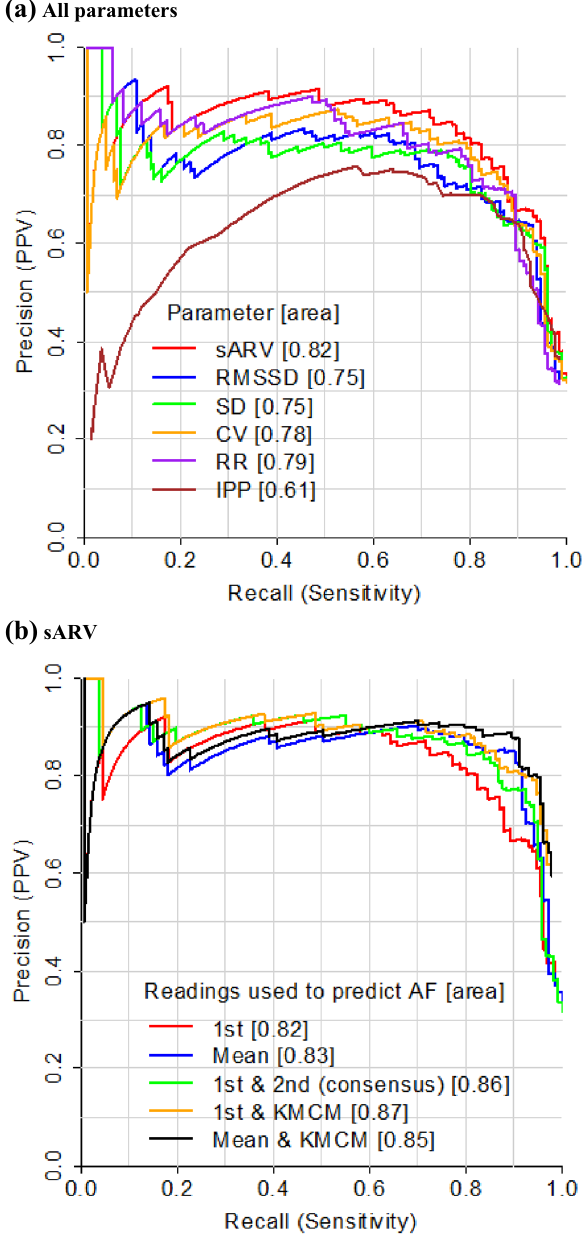
Figure 3. Precision-recall curves for AF detection by pulse rate variability (PRV) with: ( a ) all parameters and, ( b ) sARV. 1st first reading, KMCM Kardia Mobile Cardiac Monitor; other abbreviations are as for Fig. 1. For KMCM curves, AF was indicated when the PRV recording had to exceed the threshold and the KMCM output did not read “normal.” Values in brackets give area under each curve and F1 scores are reported in Supplementary Tables 1 and